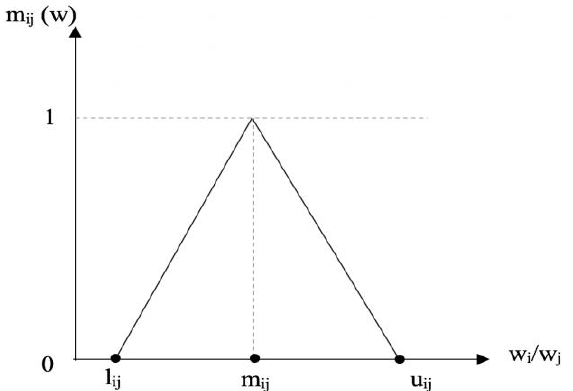
Figure 2. Graphical representation of a triangular membership function.